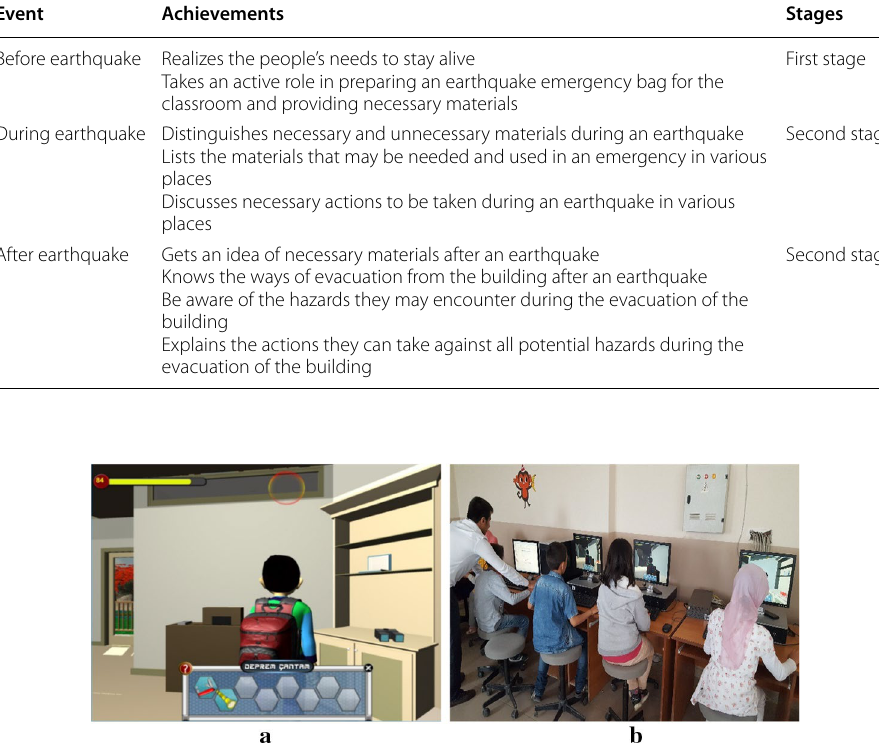
Fig. 2 a A photograph of the earthquake game. b A photograph of the implementation